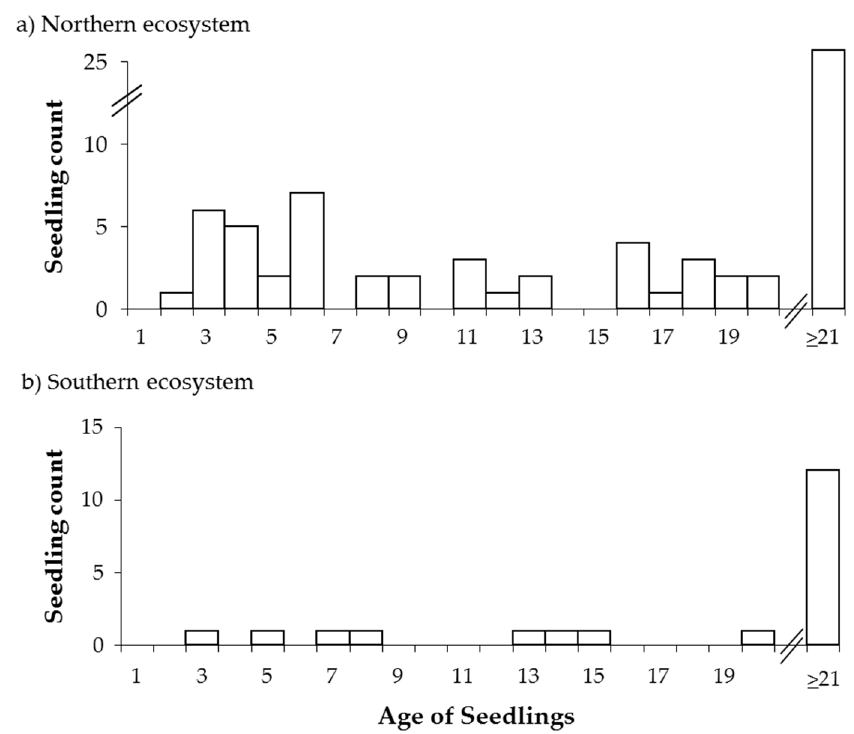
Figure 4. Timing of recent limber pine regeneration in regions with ( a ) low white pine blister rust infection (WPBR; n = 9 stands, 68 seedlings), and ( b ) high white pine blister rust (n = 8 stands; 20 seedlings). Ages are estimates from counts of terminal bud scar rings on seedlings, and all seedlings ≥ 21 + bud scars are grouped together due to difficulties aging older trees.